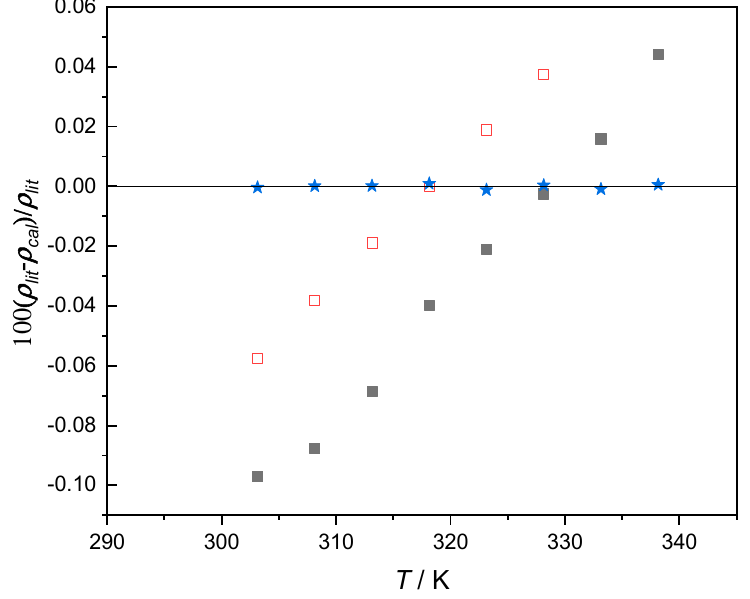
Figure 1. The deviation between the literature density ( ρ lit ) and the calculated density ( ρ cal ) using Equation (1) fitted with the experimental data in this work for [C 6 mim][OAc]: ■ ref. [10], □ ref. [11], ★ this work. Table 3. Experimental densities of [C 6 mim] [OAc] with dimethylacetamide (DMA) at (0.0967 ± 0.002) MPa from 303.15 to 338.15 K and x is IL mole fraction.